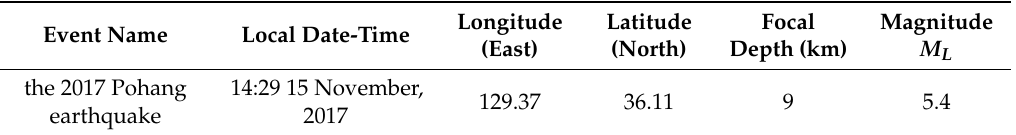
Table 1. Information on the 2017 Pohang earthquake (National Earthquake Comprehensive Information System (NECIS)).